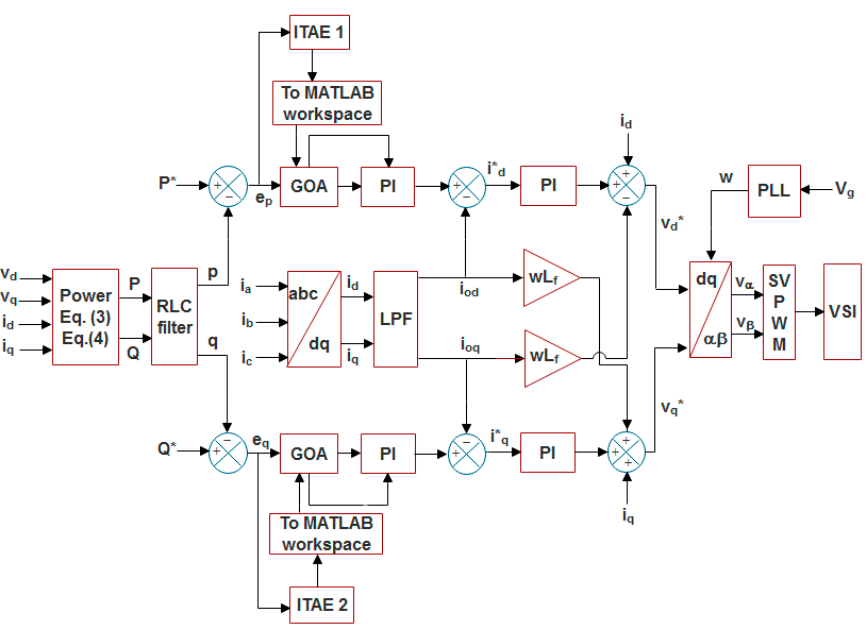
Figure 3. Proposed optimal power flow control strategy.